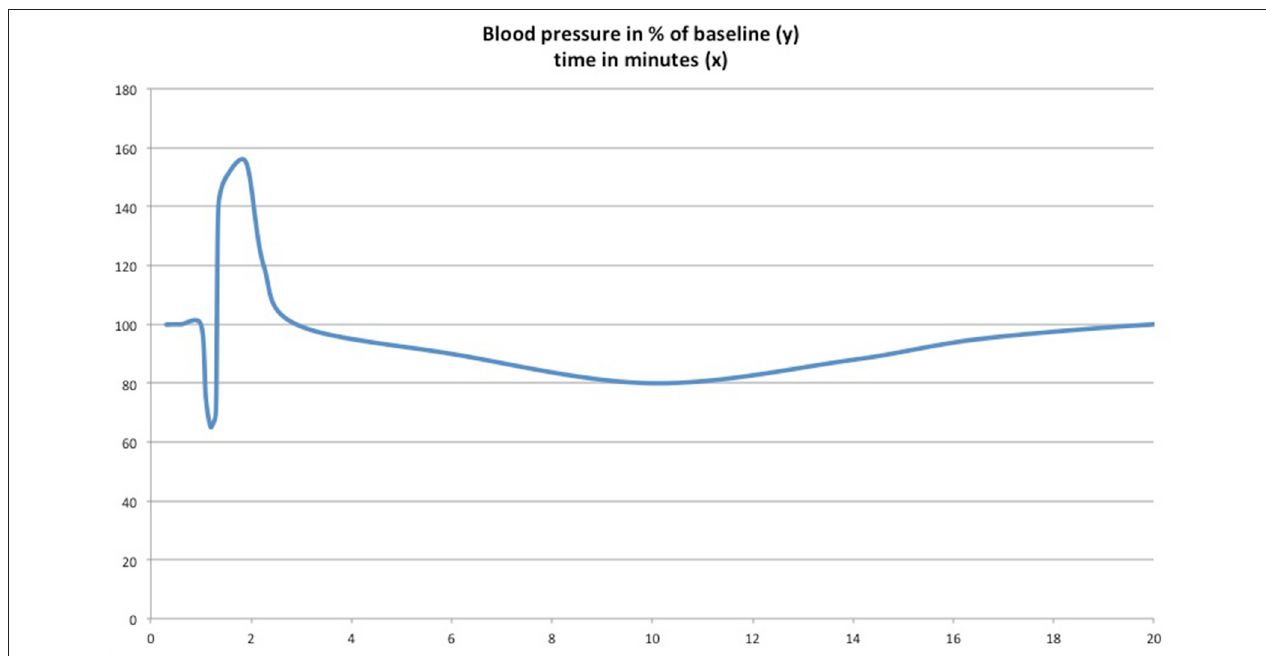
FIGURE 3 | The “triple effect” or “triphasic effect.” Upon injection of 1 -9-THC (Siqueira et al., 1979) and anandamide (Varga et al., 1996) in urethane-anesthetized rats, an initial drop in blood pressure is followed by a short-lasting blood pressure peak mediated by vasoconstriction and then by delayed moderate and transient hypotension. Scheme adapted from the results of the aforementioned